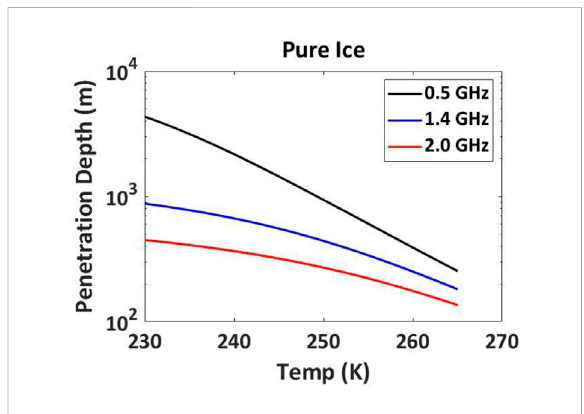
FIGURE 1 Penetration depths in ice along the optical path as a function of ice temperature for 0.5 (black), 1.4 (blue) and 2 (red) GHz. The Matzler model of dielectric permittivity is used to calculate the penetration depths (Matzler,